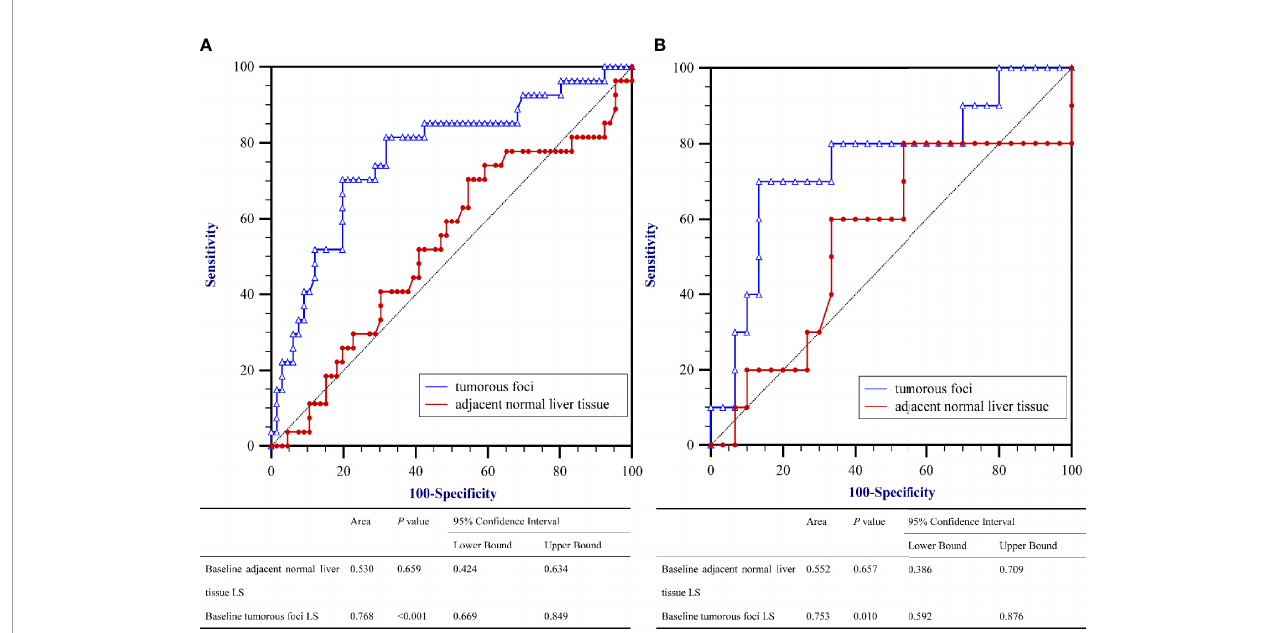
FIGURE 2 | Area under the receiver operating characteristics curves (AUROC) for predicting Progressive Diseases (PD) after therapy with anti – programmed cell death protein 1 (PD-1) plus lenvatinib using baseline liver stiffness (LS) values of tumorous foci. (A) The training set (n = 93) and (B) the validation set (n =